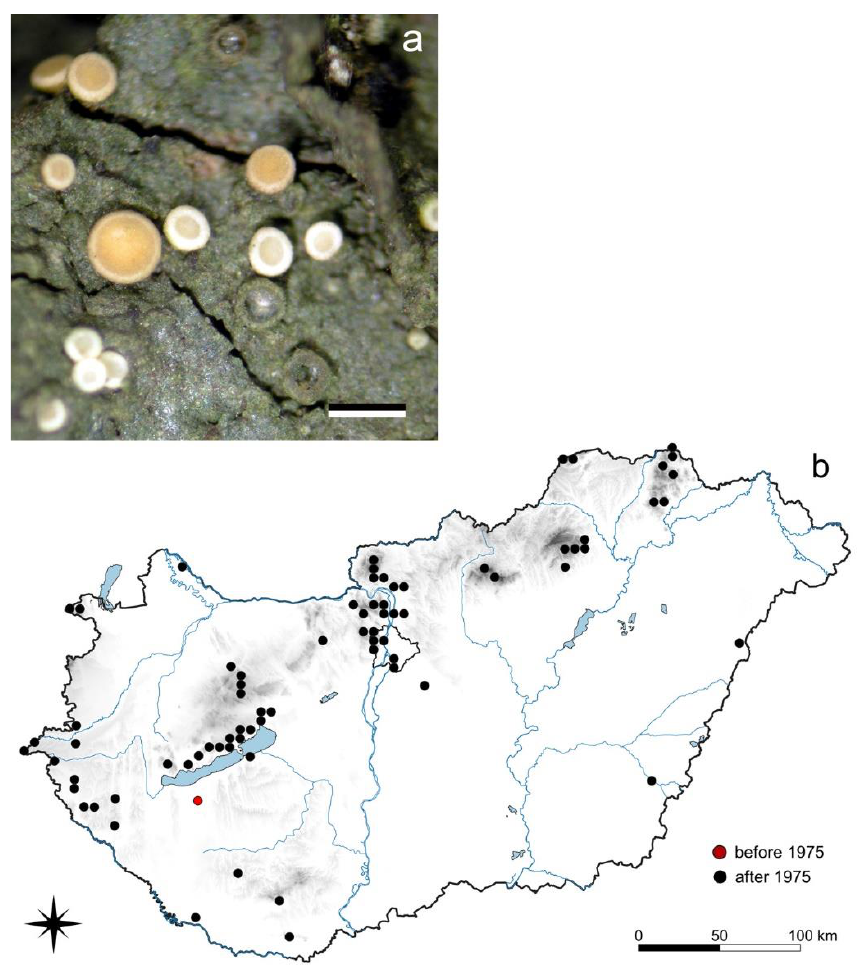
Figure 5. Coenogonium pineti ( a ) habit (scale 0.5 mm); ( b ) its distribution in Hungary (101 records, 1954 – 2022). Dots represent c. 5 km × 6 km areas. (Photo: E. Farkas).